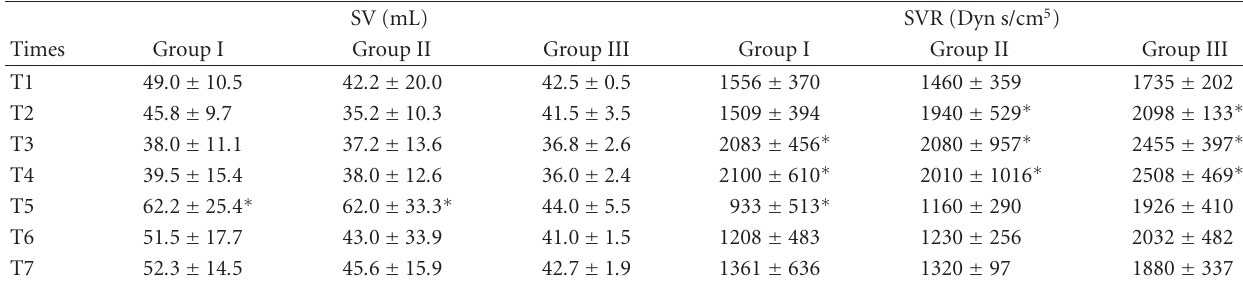
Table 3: Systolic volume (SV) and and systemic vascular resistance (SVR) in pigs anesthetized with sevoflurane, fentanyl, and vecuronium and undergoing aortic cross-clamping through laparotomy (Group I) or laparoscopy with (Group II) or without aortic cross-clamping (Group III).